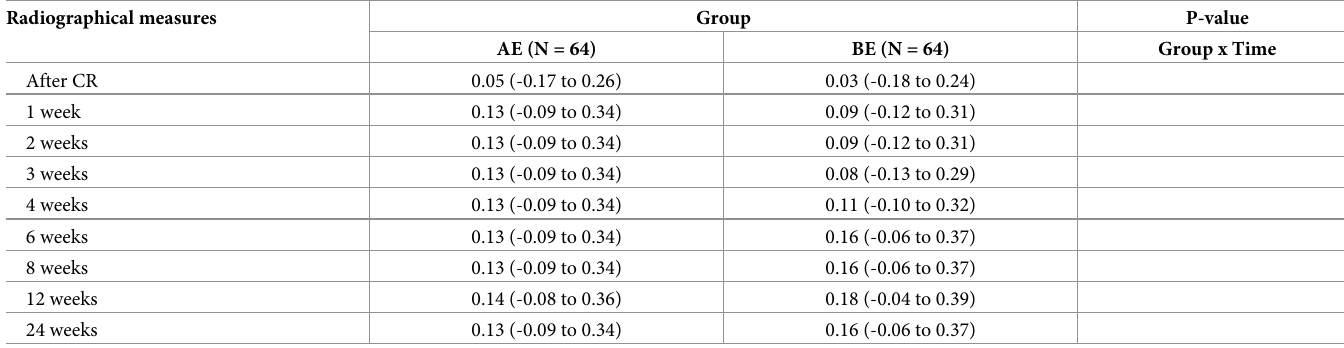
deviation: AE: 35.37 (32.37 to 38.38), BE: 35.66 (32.64 to 38.69), p = 0.740. No statistically